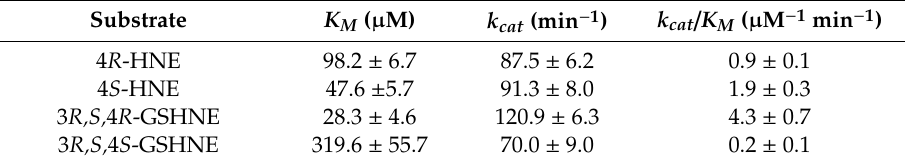
Table 1. Kinetic parameters of h AKR1B1 for HNE and GSHNE